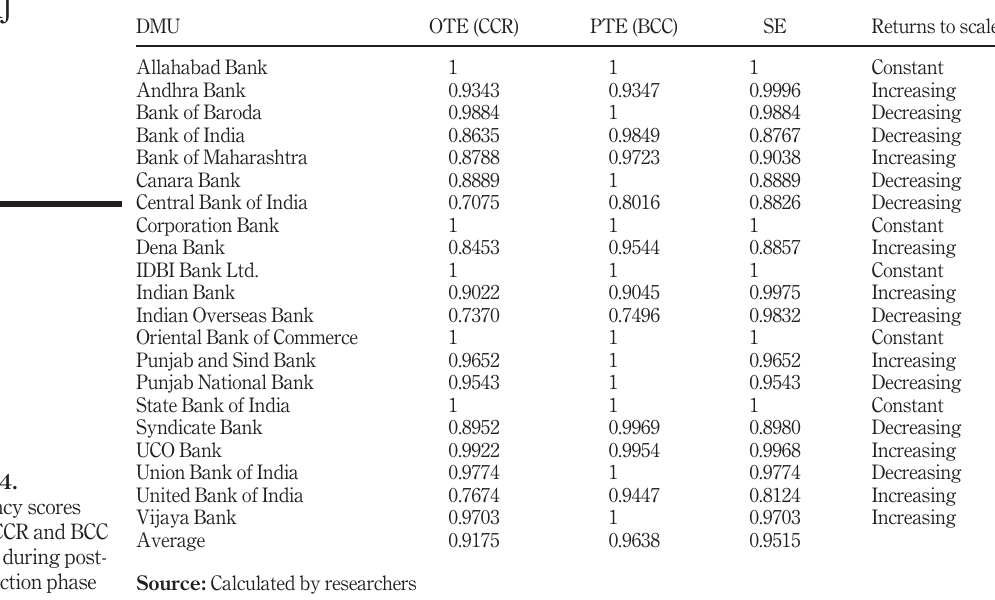
Table 4. Ef fi ciency scores under CCR and BCC models during